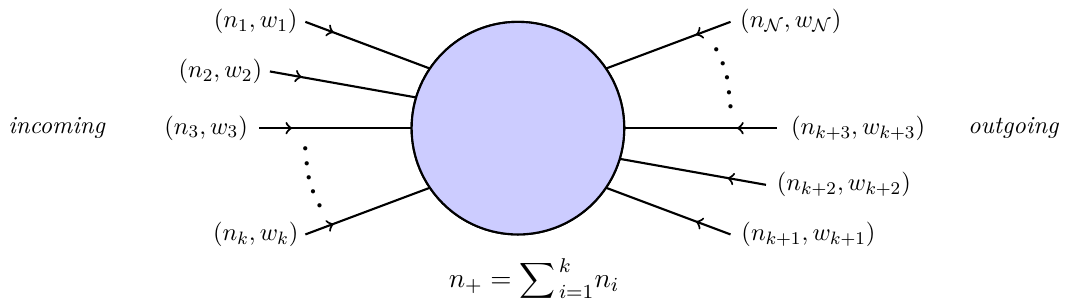
Figure 1. Closed string amplitude with momentum and winding data ( n i , w i ) obeying conservation laws P N n i = 0 and P N w i = 0 . We choose n 1 , . . . , n k > 0 and n k +1 , . . . , n N ≤ 0 , splitting i =1 i =1 strings into incoming and outgoing states. The integer n + is the total incoming momentum. We show that the number of D-branes in the open string scattering amplitude appearing in the KLT- like factorization is n + + 1 .